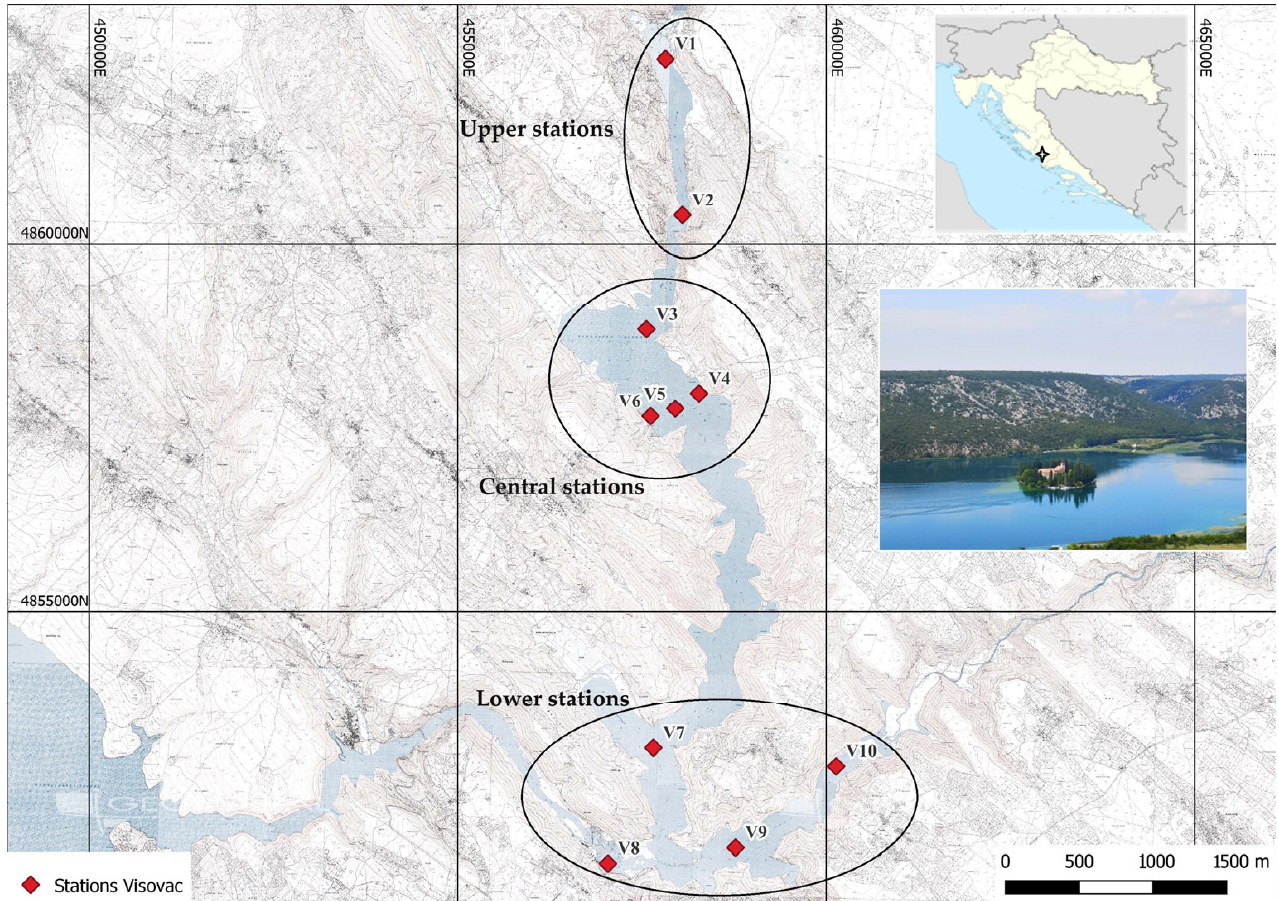
Figure 1. Sampling stations on Lake Visovac during August 2018.